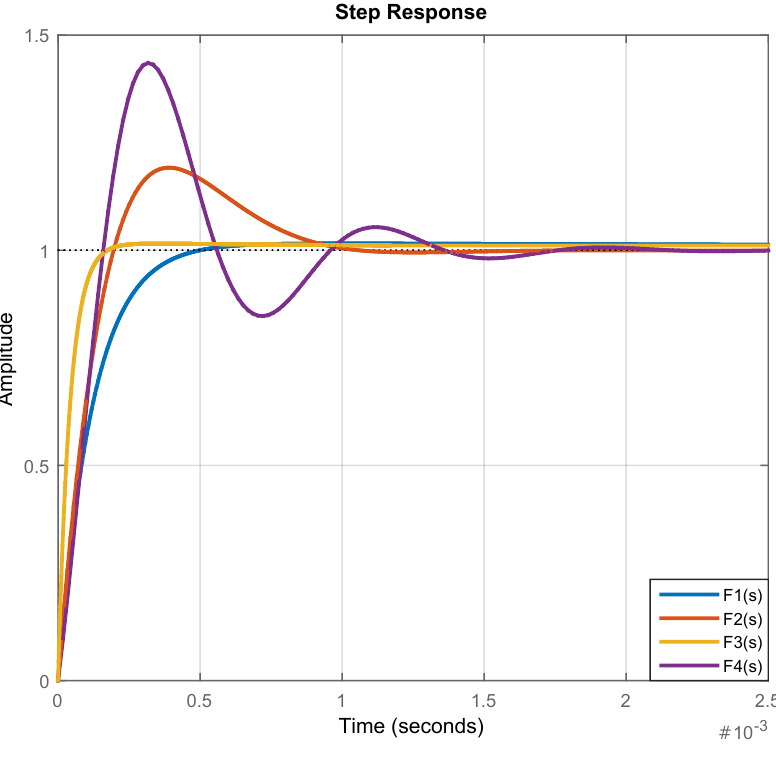
Figure 6. Step response of the reference-tracking closed-loop transfer function.